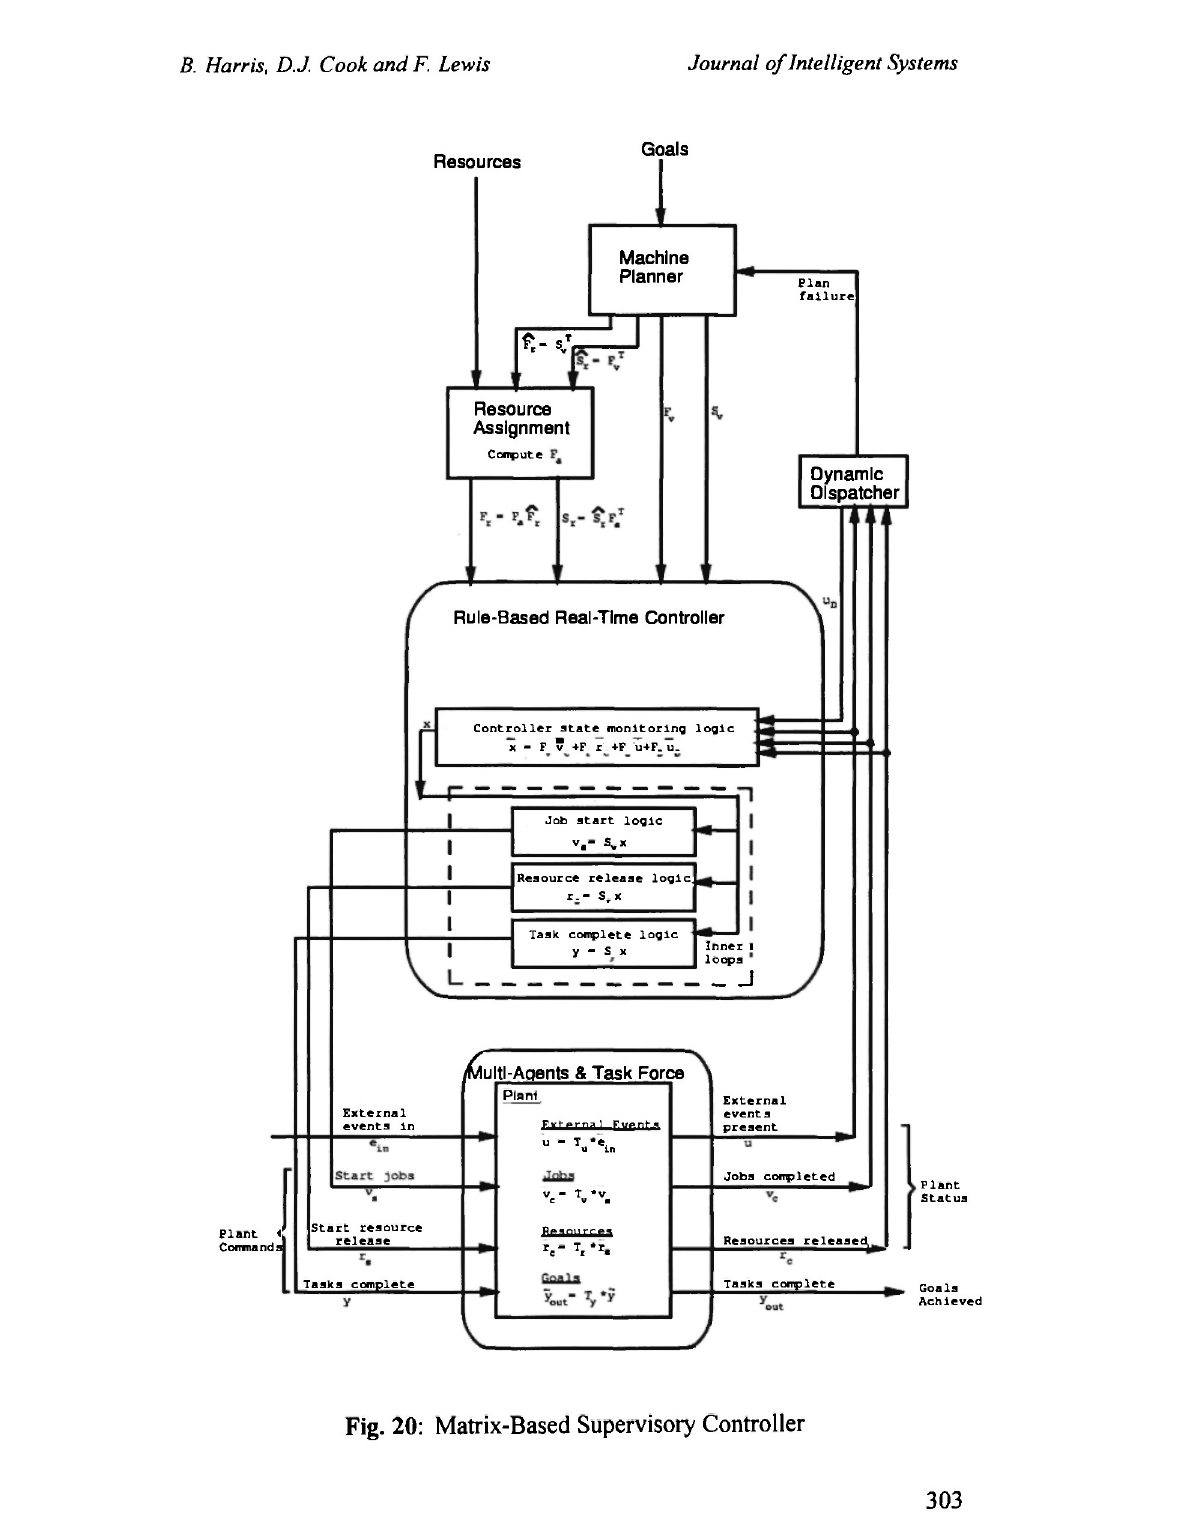
Fig. 20: Matrix-Based Supervisory